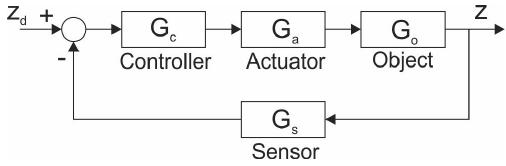
Figure 3. The basic block diagram of the